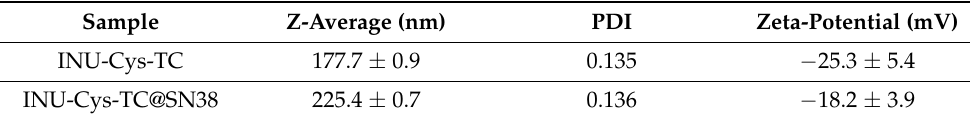
Table 2. The DLS measurements of the zeta-average and zeta-potential of SN38-loaded and empty INU-Cys-TC